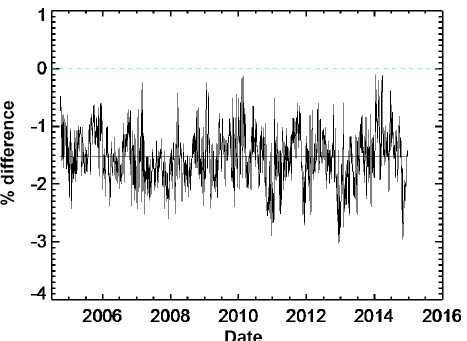
Figure 10. Weekly mean percent difference of OMI ozone minus ground-based averages from an ensemble of 76 Northern Hemi- sphere Dobson–Brewer stations with linear fit (from McPeters et al., 2015).